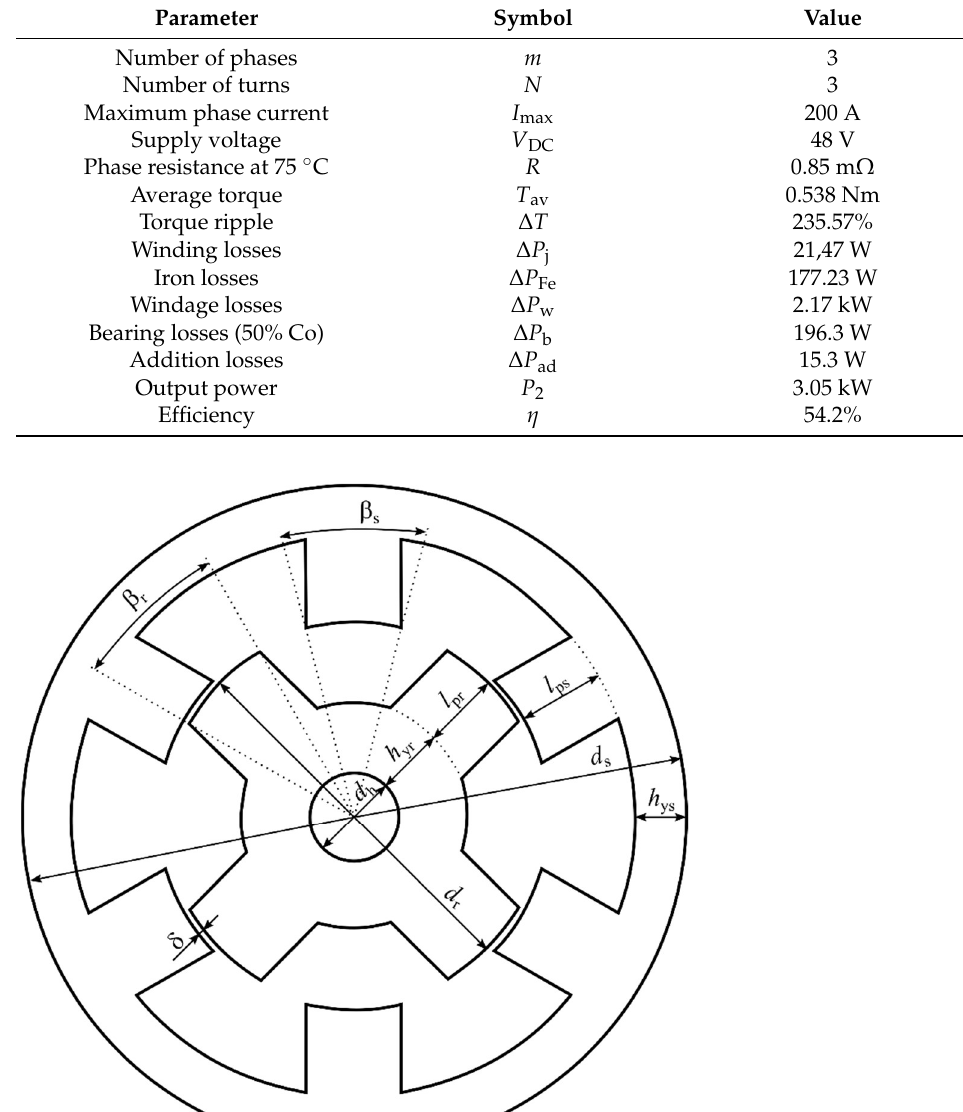
Table 2. Summary of the electrical parameters of the basic high-speed SRM design.